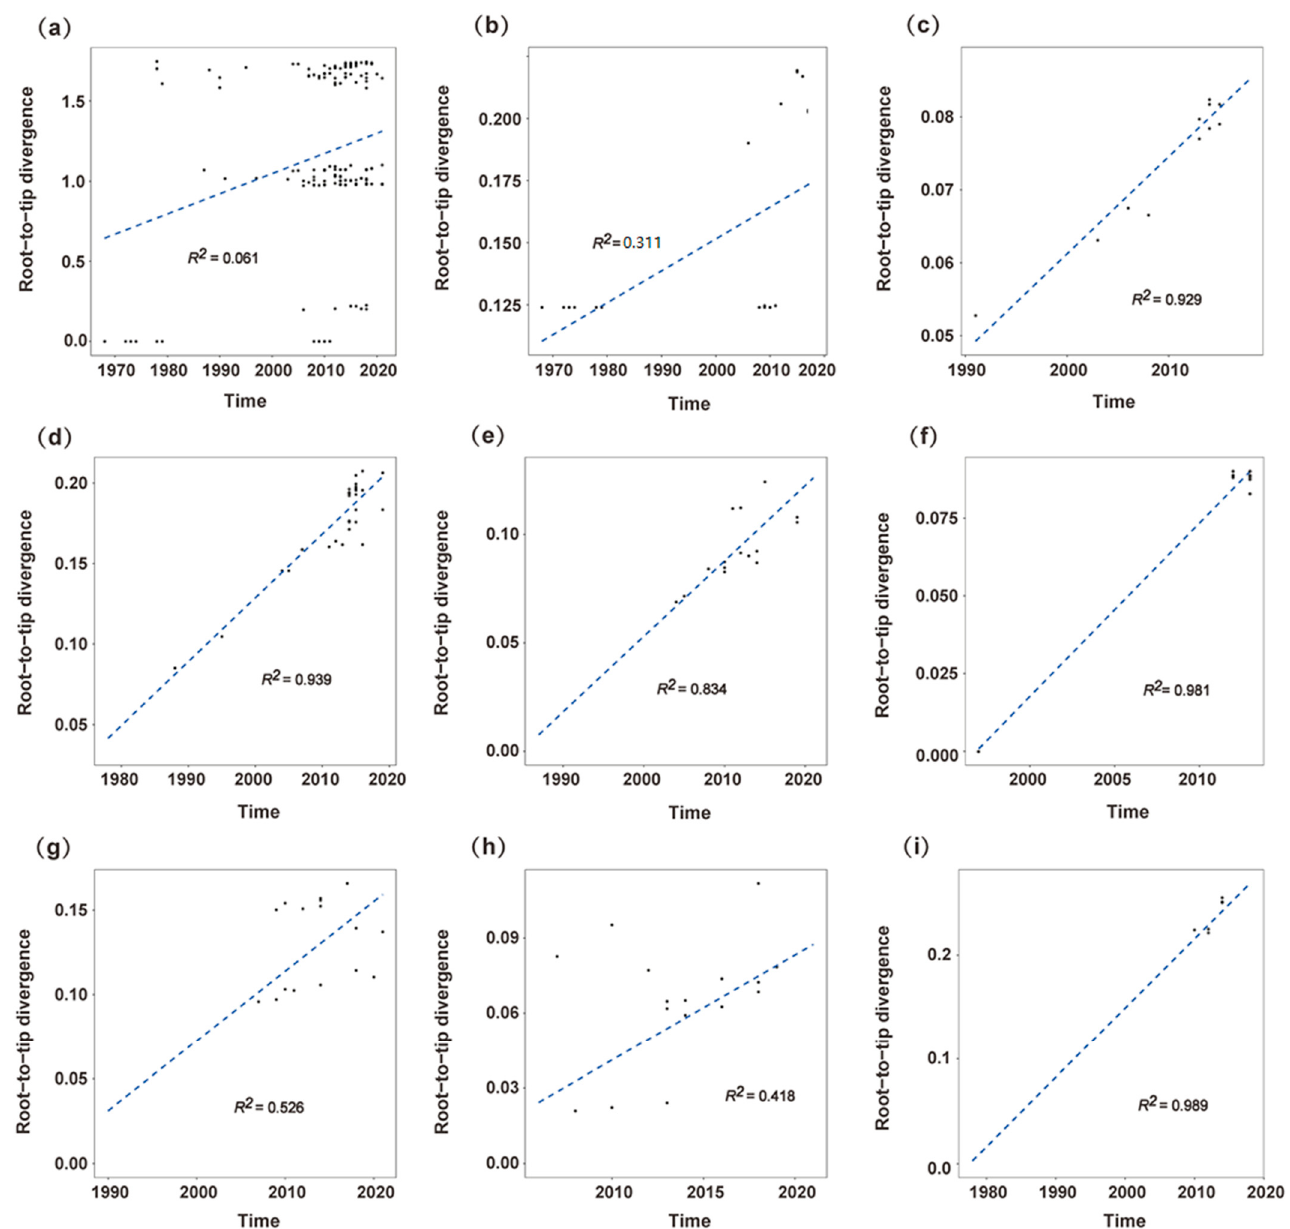
Figure 2. Root-to-tip divergence plots of norovirus GI RdRp gene: ( a ) all strains, ( b ) GI.P1, ( c ) GI.P2, ( d ) GI.P3, ( e ) GI.P4, ( f ) GI.P6, ( g ) GI.P7, ( h ) GI.P11, ( i ) GI.P13. The X-axis represents the isolation time, and the Y-axis is the root-to-tip divergence inferred from maximum likelihood tree. Blue dashed line means a linear regression line.